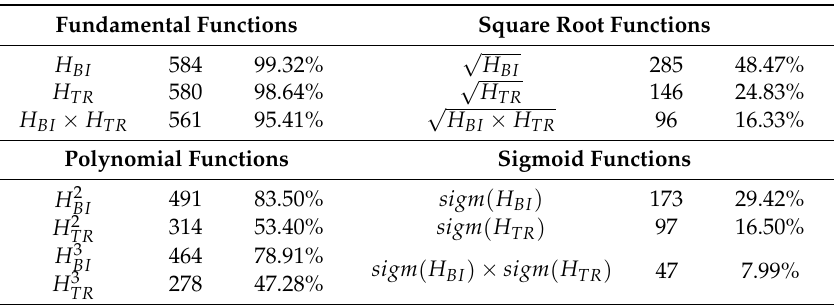
Figure 6. Illustration of the measured force and the estimated force for Subject 1 at 40% MVC task. Table 2. Times and frequency of basis function selection for all subjects.